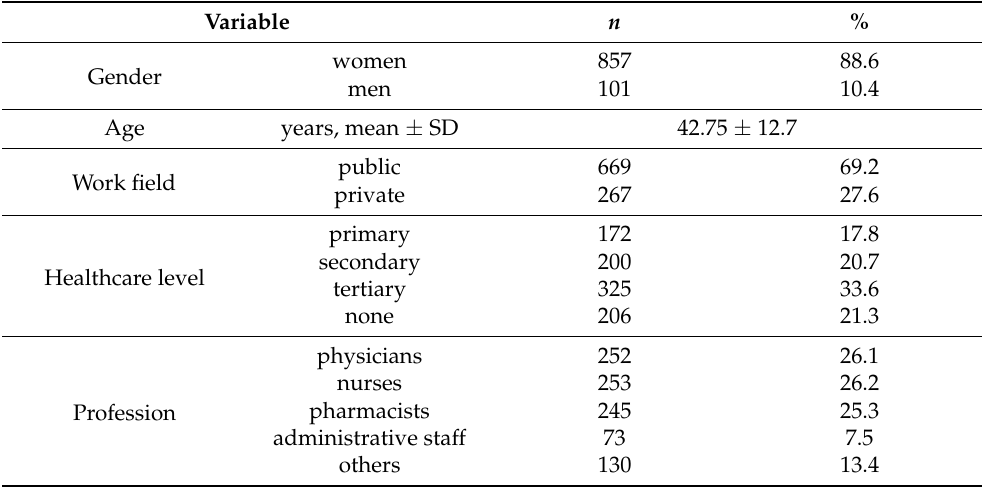
Table 1. Basic Characteristics of the Study Sample. Baseline Characteristic.